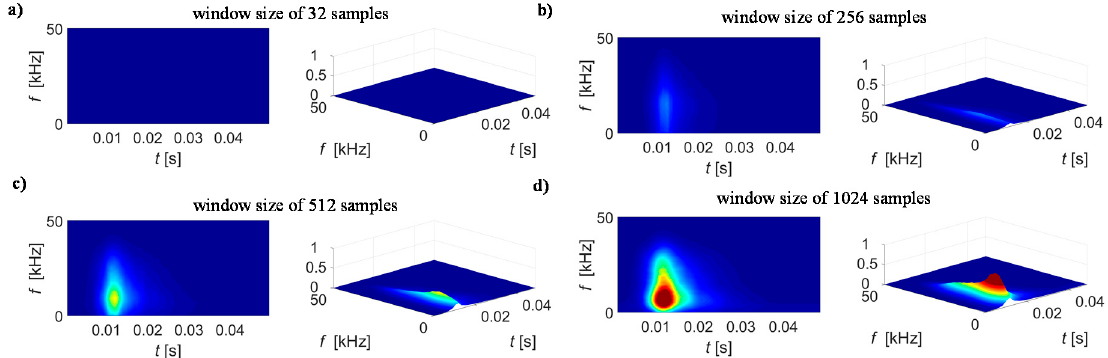
Figure 6. Spectrograms obtained for window size of: ( a ) 32 samples, ( b ) 256 samples, ( c ) 512 samples, ( d ) 1024 samples.